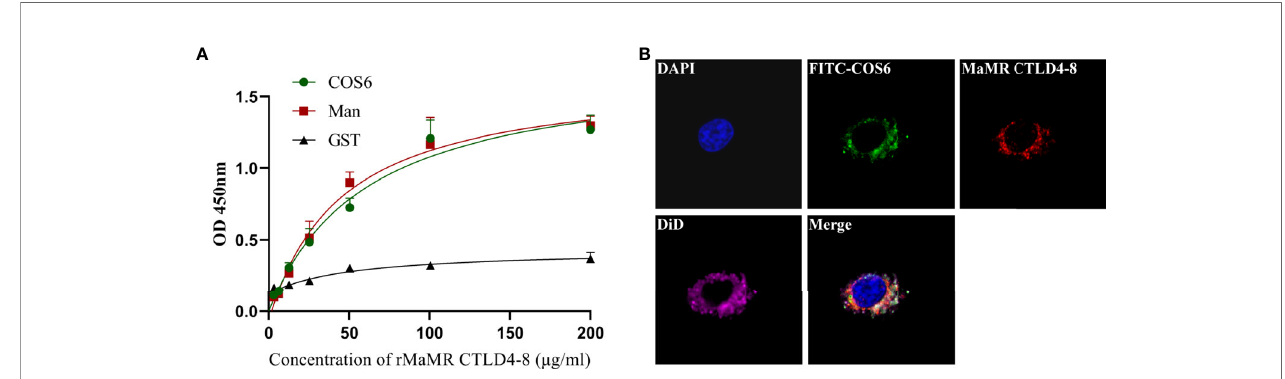
FIGURE 2 | Interaction of chitooligosaccharide hexamer (COS6) to mannose receptor C-type lectin-like domain 4-8 of Megalobrama amblycephala (MaMR CTLD4-8). (A) ELISA analysis of the interaction between rMaMR CTLD4-8 and COS6. The microtiter plates were coated with carbohydrates (Man as a positive control) and incubated with the recombinant protein [glutathione-S-transferase (GST)-tag protein as a negative control]. After incubation with anti-MaMR CTLD4-8 antibody, the interaction was detected with goat anti-mouse immunoglobulin G (IgG) – horseradish peroxidase (HRP) conjugate at 450 nm. (B) Co-localization of COS6 and MaMR CTLD4-8 by indirect immuno fl uorescent assay. Primary macrophages were incubated with fl uorescein isothiocyanate (FITC)-labeled COS6 for 30 min, 4% (v/v) paraformaldehyde- fi xed, anti-MaMR CTLD4-8 incubated, labeled with Cy3, 4 ′ ,6-diamidino-2-phenylindole (DAPI), and 1,1-dioctadecyl-3,3,3,3- tetramethylindodicarbocyanine (DiD) staining, and the results were presented via confocal microscopy. Data were shown as means ± SD (n = 3). Scale bar:10 m